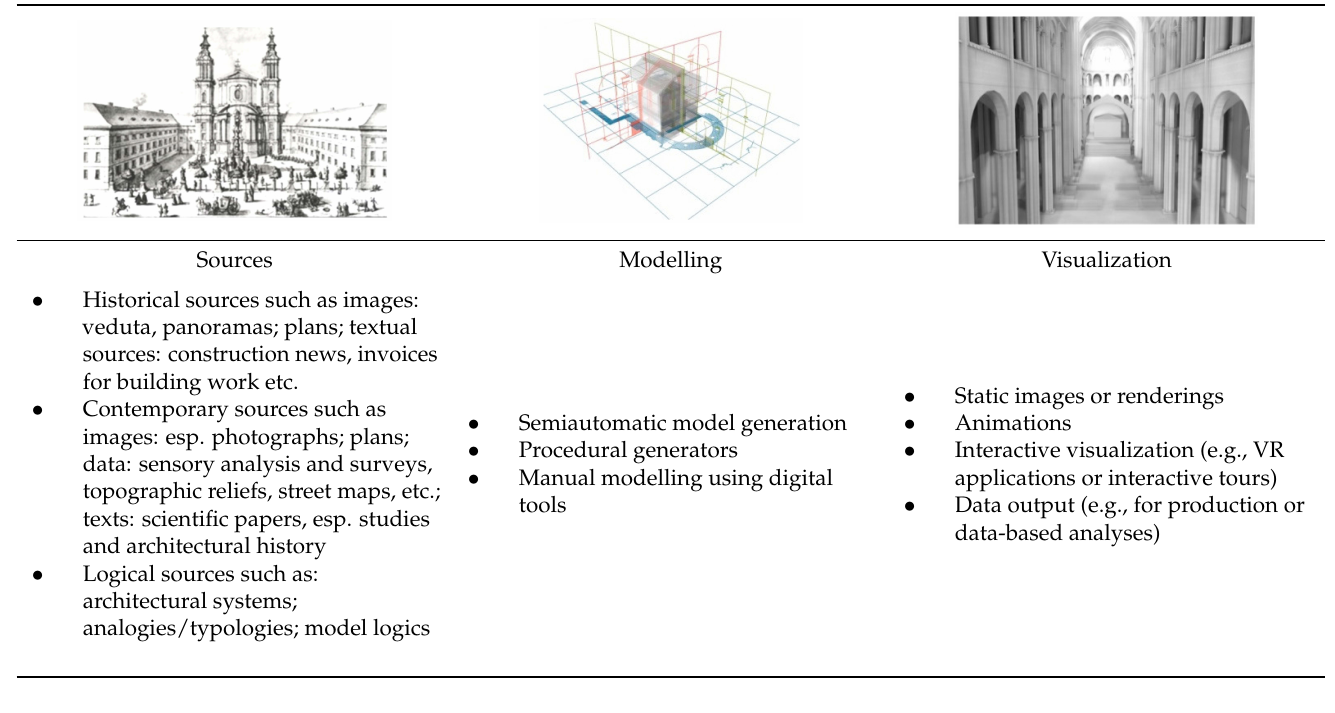
Table 4. Classification of the digital 3D reconstruction process as regards sources, modelling, and